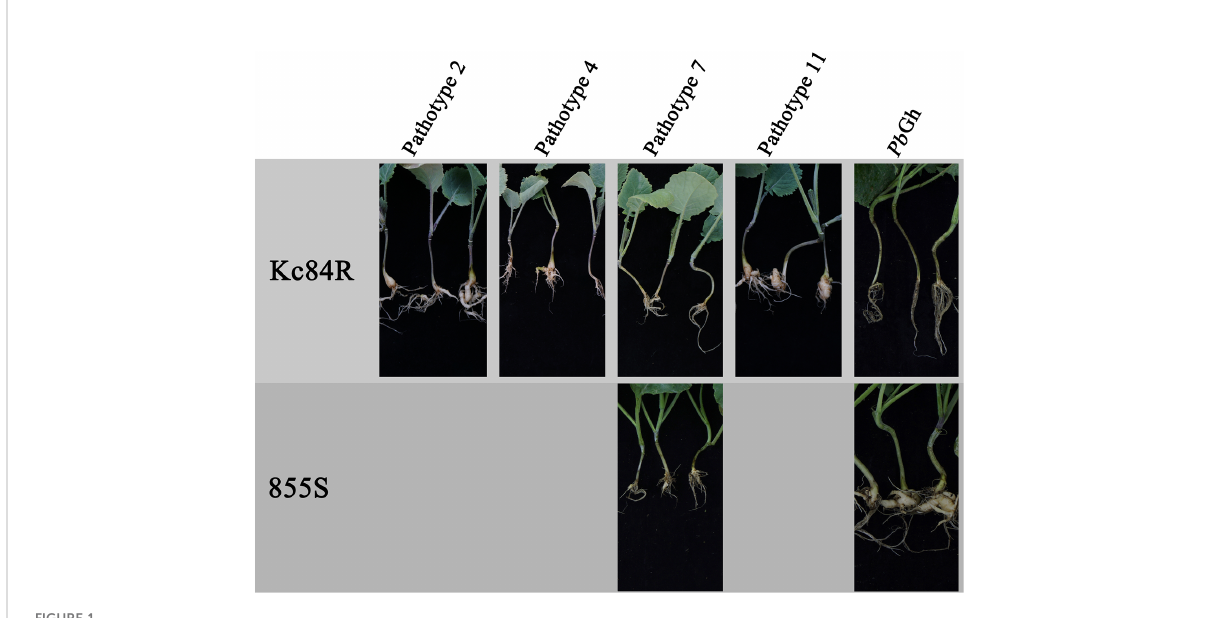
FIGURE 1 Phenotypes of parent materials to P. brassicae